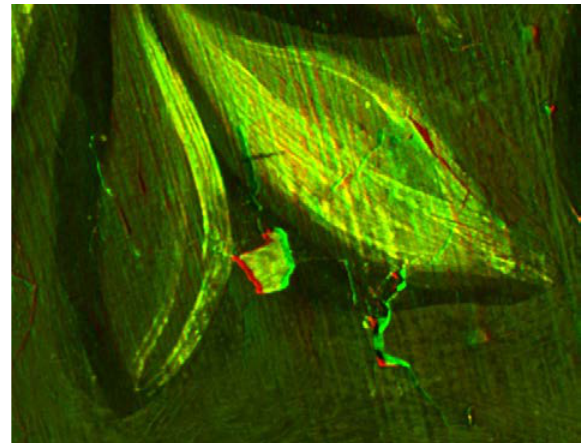
Figure 8. False-colour composite of same pair of images as in Fig. 4, after alignment. The intensity differences caused by illumination from the opposite directions are apparent.